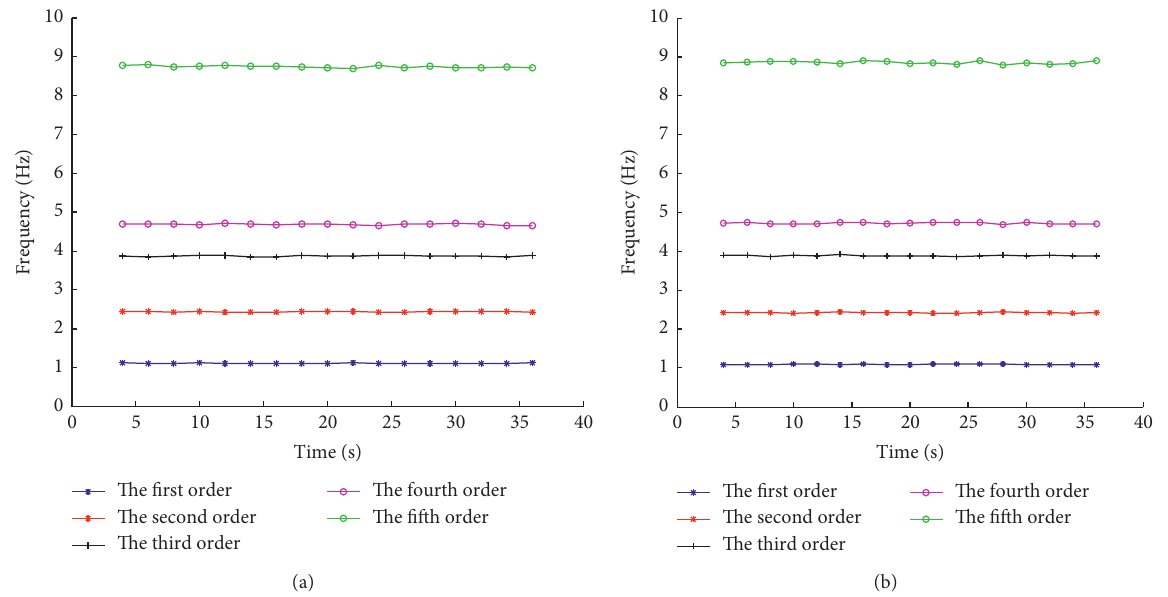
Figure 11: Frequency trend chart. (a) Frequency trend chart (working condition: C1). (b) Frequency trend chart (working condition: S1).